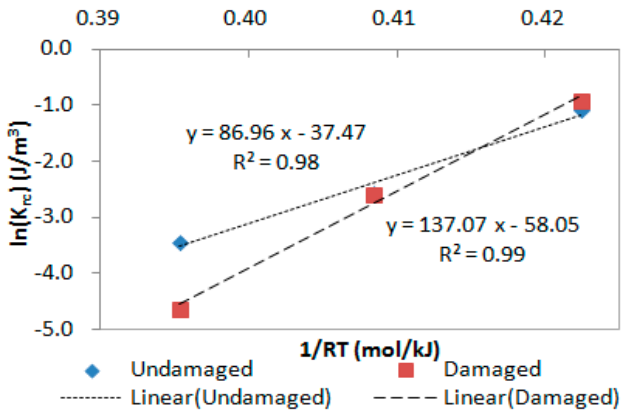
Figure 8. Calculation example of E arc and A rc for base binder at 15 ◦ C, 25 ◦ C, and 35 ◦ C.